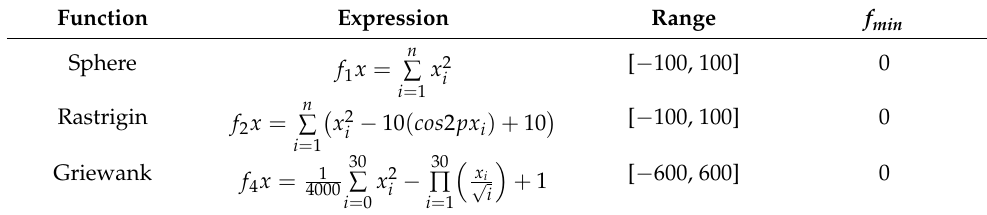
Table 12. The information of benchmark